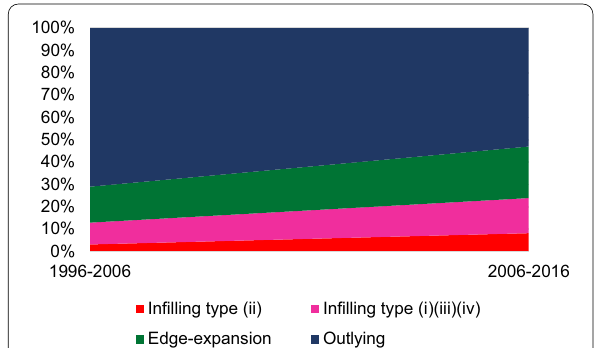
Fig. 6 Percentage of built-up patches in each micro-pattern in the city-region